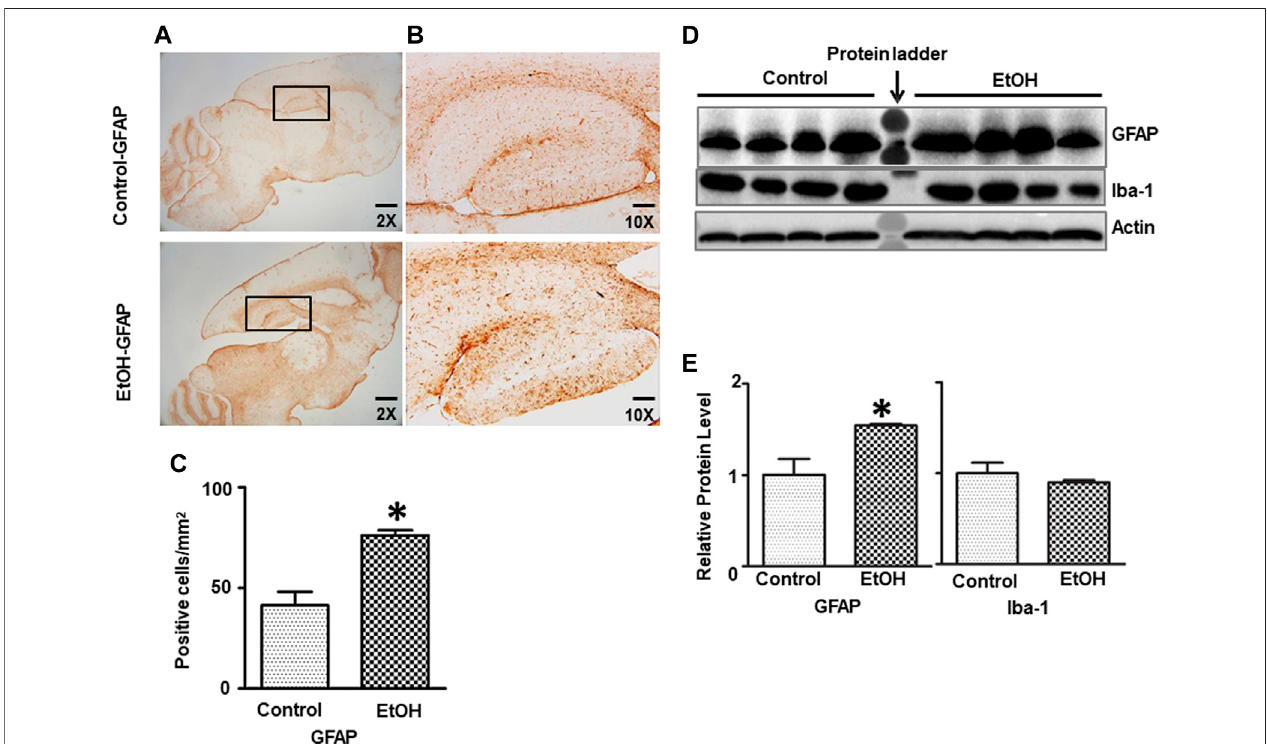
FIGURE6| Effectsofchronicethanolexposureonastrocyteactivation. (A) TheexpressionofGFAPinthemousebrainwasexaminedbyIHC.Therectangleinsets indicateanareaofthehippocampus. (B) Therectangleinsetsin (A) areshowninhighermagni fi cations. (C) TheGFAP-positivecellsinthehippocampuswerequanti fi ed. Theresultwasexpressedasthemean ± SEM,n (cid:2) 3foreachgroup.* p < 0.05denotesastatisticallysigni fi cantdifferencefromthecontrolgroup. (D) Theproteinlevelsof GFAP were examined by IB. (E) The relative amounts of GFAP expression were quanti fi ed and normalized to the expression of actin. The result was expressed as the mean ± SEM, n (cid:2) 4 for each group. * p < 0.05 denotes a statistically signi fi cant difference from the control group.